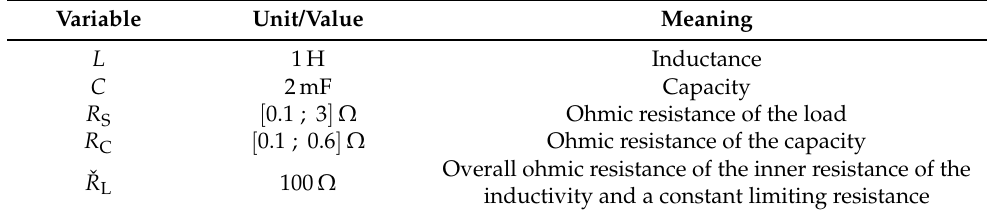
Table 1. Parameters of the low-power electrical circuit.